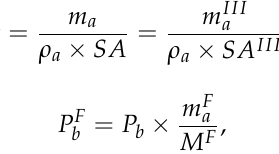
Table 8. Proportion of the specific surface area of the asphalt mixture. Sieve Size Effective Density of (mm)